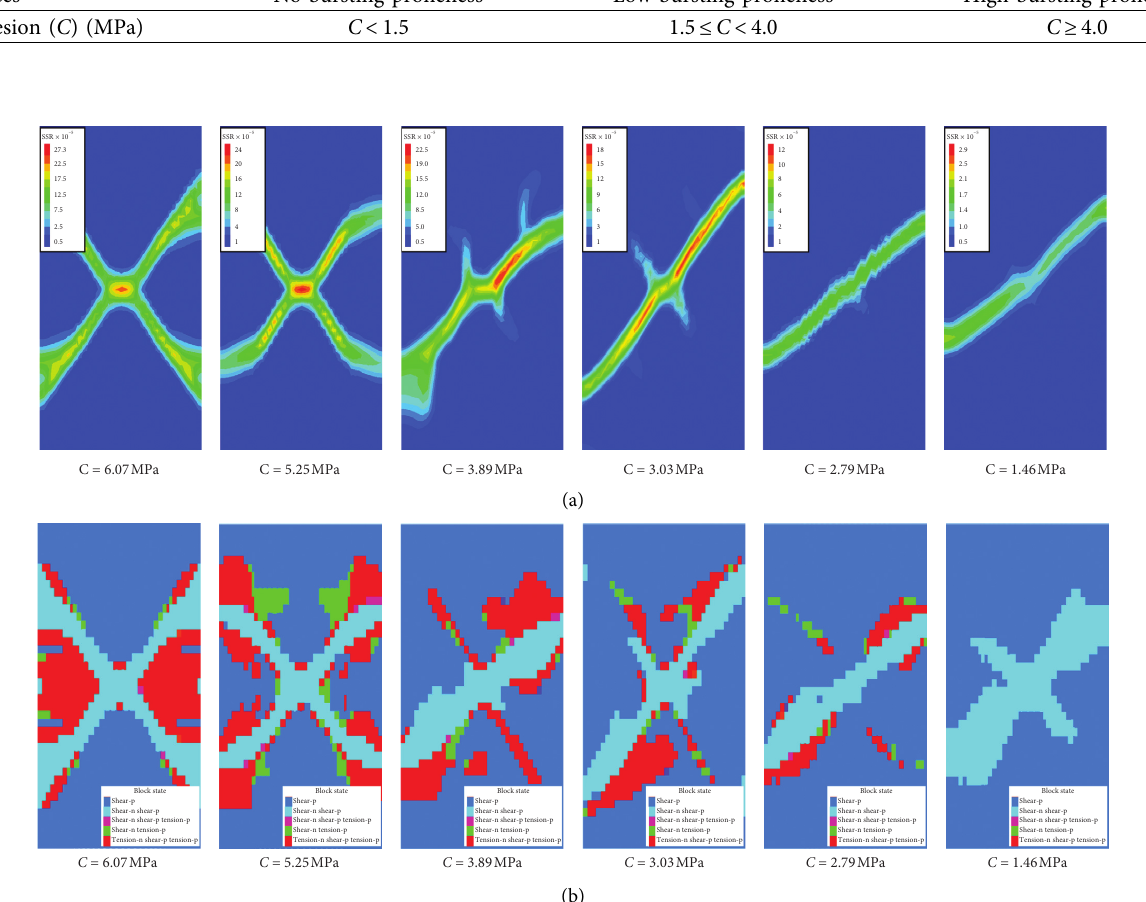
Figure 13: Contours of SSR and plastic zones calculated by FLAC 3D for coal specimens with different cohesion: (a) contours of SSR; (b) plastic zones.